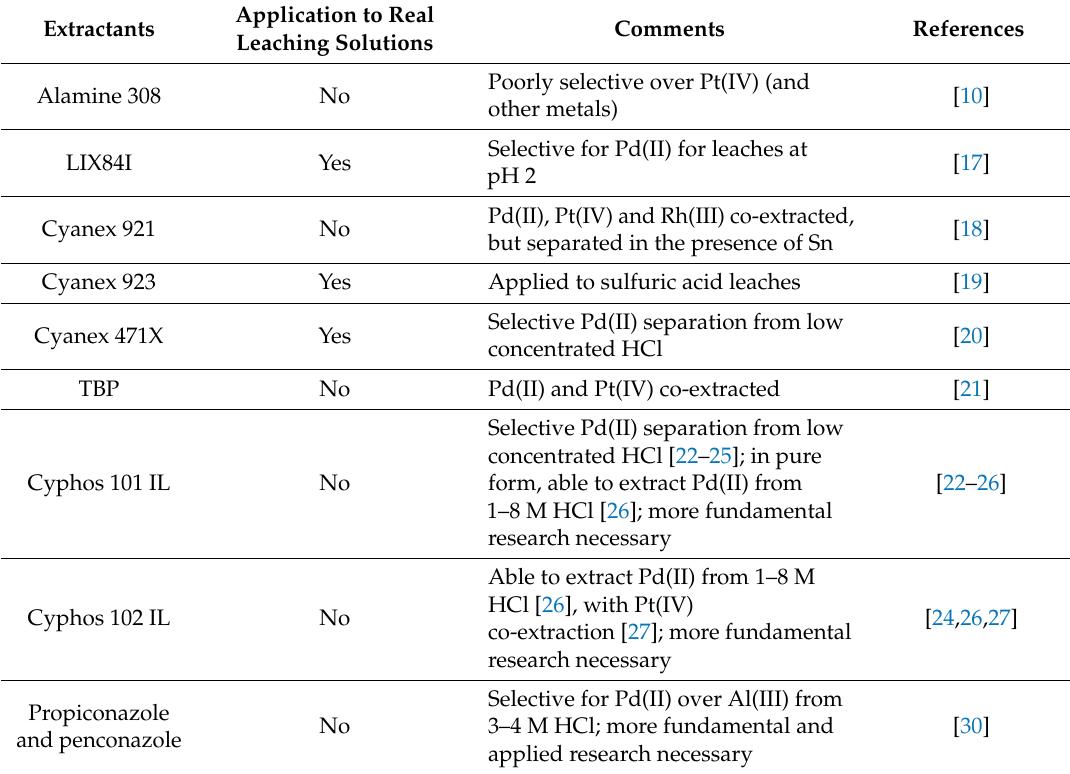
Table 2. Commercial extractants for Pd(II) recovery from catalysts leaching solutions (IL: ionic liquid).